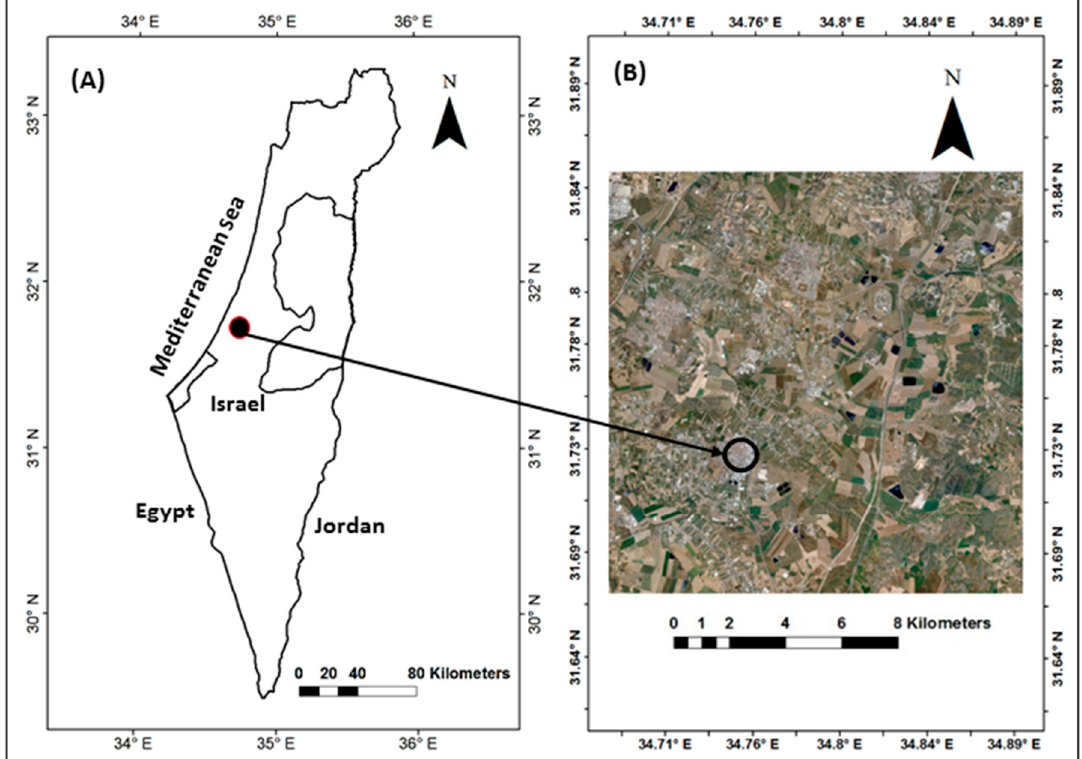
Figure 1. ( A ) Location of the study area in Israel, ( B ) zoom-in on the city of Kiryat Malakhi.